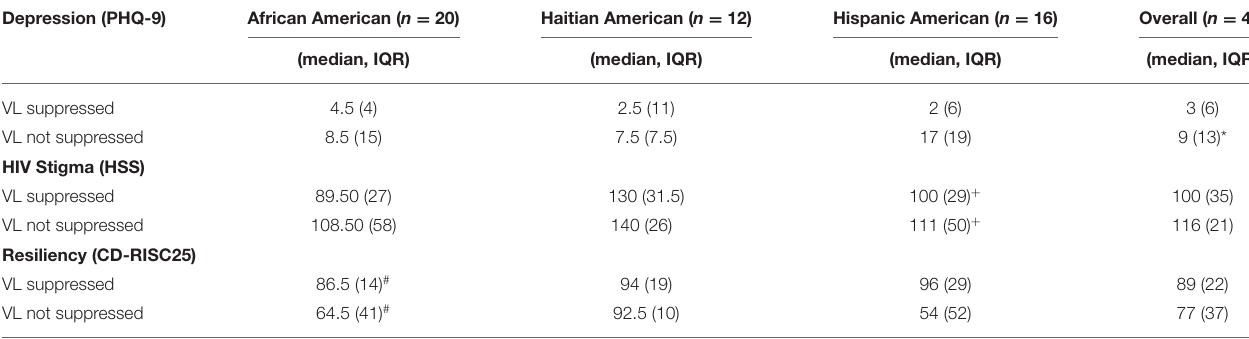
TABLE 3 | Assessments by ethnicity and HIV viral